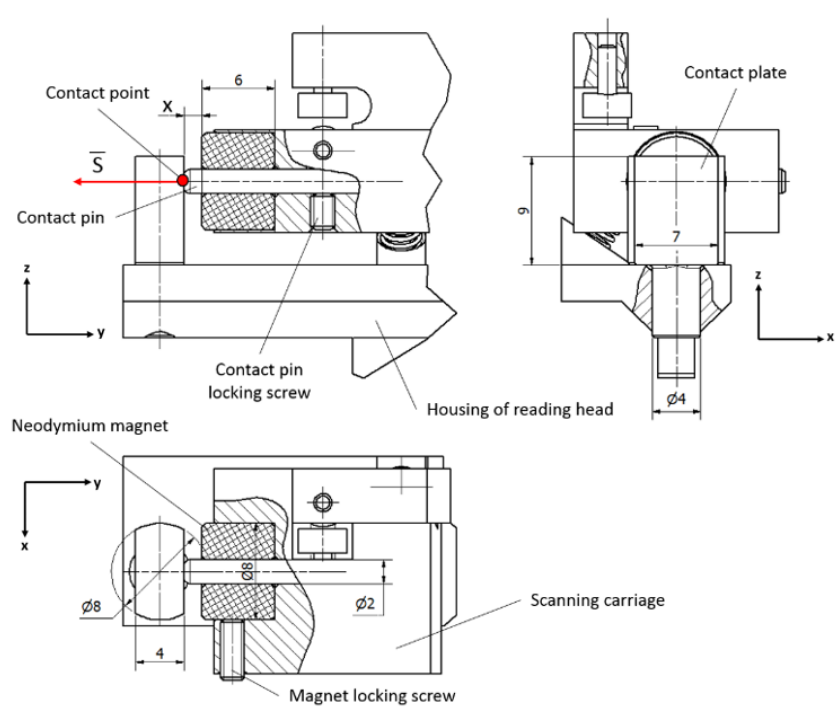
Figure 7. Mechanical construction of contact pair A.